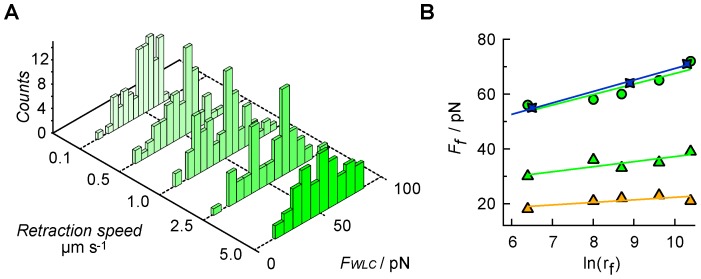
Dynamic force spectroscopy.(A) Rupture force distributions obtained at different retraction speeds for the homotypic E1-5 bond rupture. (B) Rupture force F
f as a function of loading rate for homotypic E1-5 (green symbols) or heteromeric E1-2/E1-5 bond rupture (orange symbols). The different symbols represent the maxima identified in the multimodal distribution of rupture force obtained for a given loading rate. For the homotypic E1-5 bond we determined xu  =  1.1 nm and koff  =  1.2 × 10−4 s−1 (green circles); xu  =  2.3 nm and koff  =  1.4 × 10−5 s−1 (green triangles). For the heteromeric E1-5/E1-2 bond we determined xu  =  4.5 nm and koff  =  5.9 × 10−7 s−1 (yellow triangles). The violet stars indicate data taken from [41].